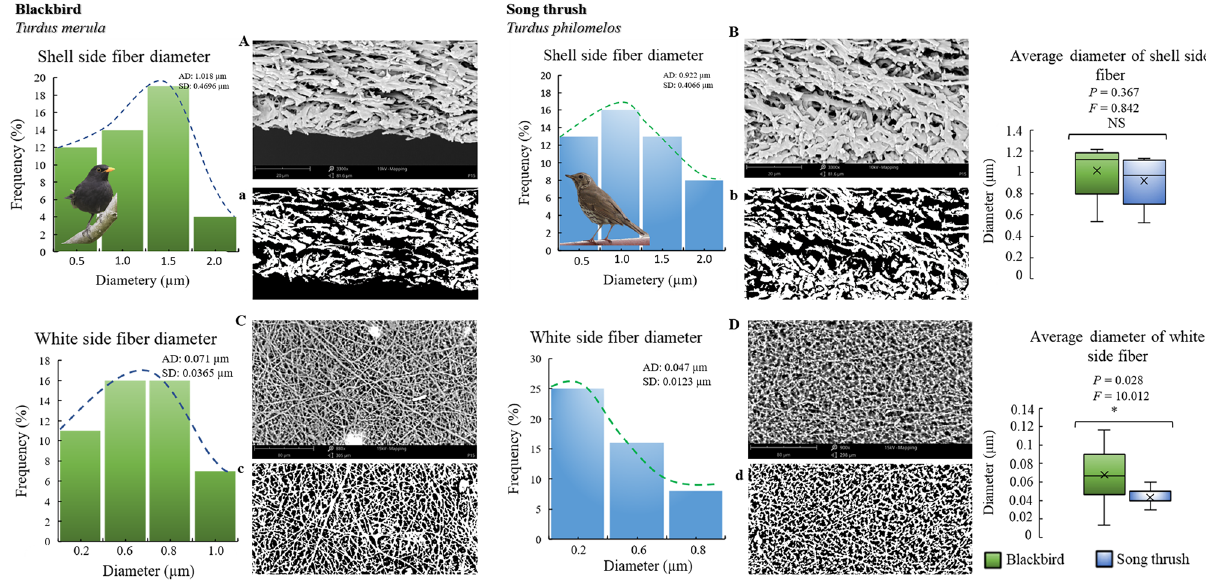
Figure 4. Variability and diameter of the shell-side and white-side membrane fibers of blackbird and song thrush eggshell, based on SEM micrographs ( A – D ) and binary image (a-d) (MultiScanBase v. 18.03). The histograms show the diameter distribution of the fibers (AD: average diameter, SD: standard deviation). Box plots show the means (cross), standard deviation (box height), and the low and high range (vertical bars) of fiber